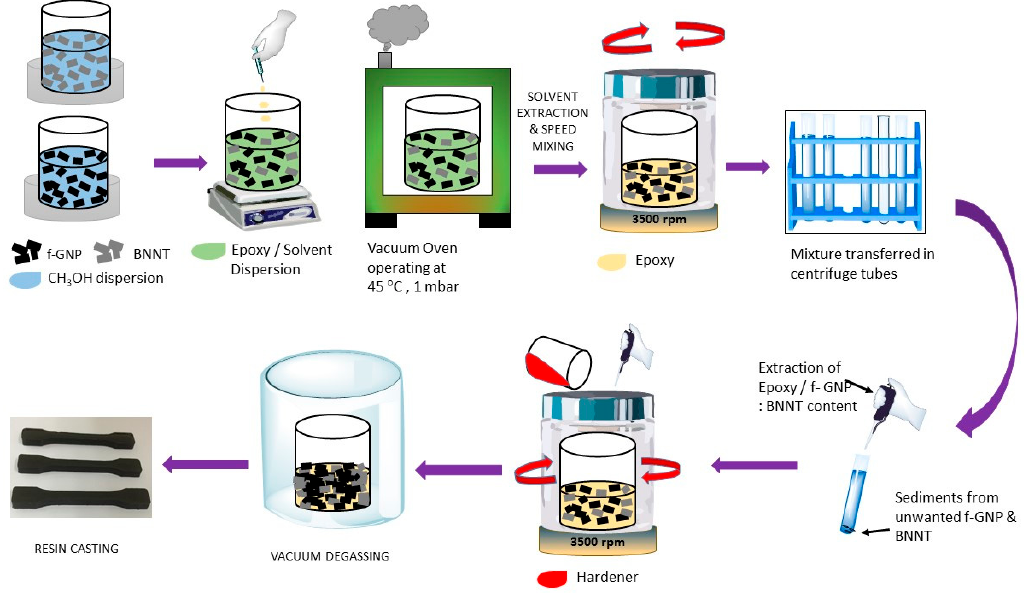
Figure 11. Schematic diagram of the processing of the f-GNP/BNNT based epoxy nanocomposite.